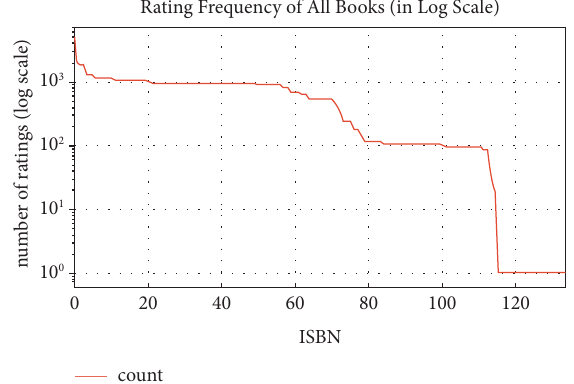
Figure 2: Rating frequency of all